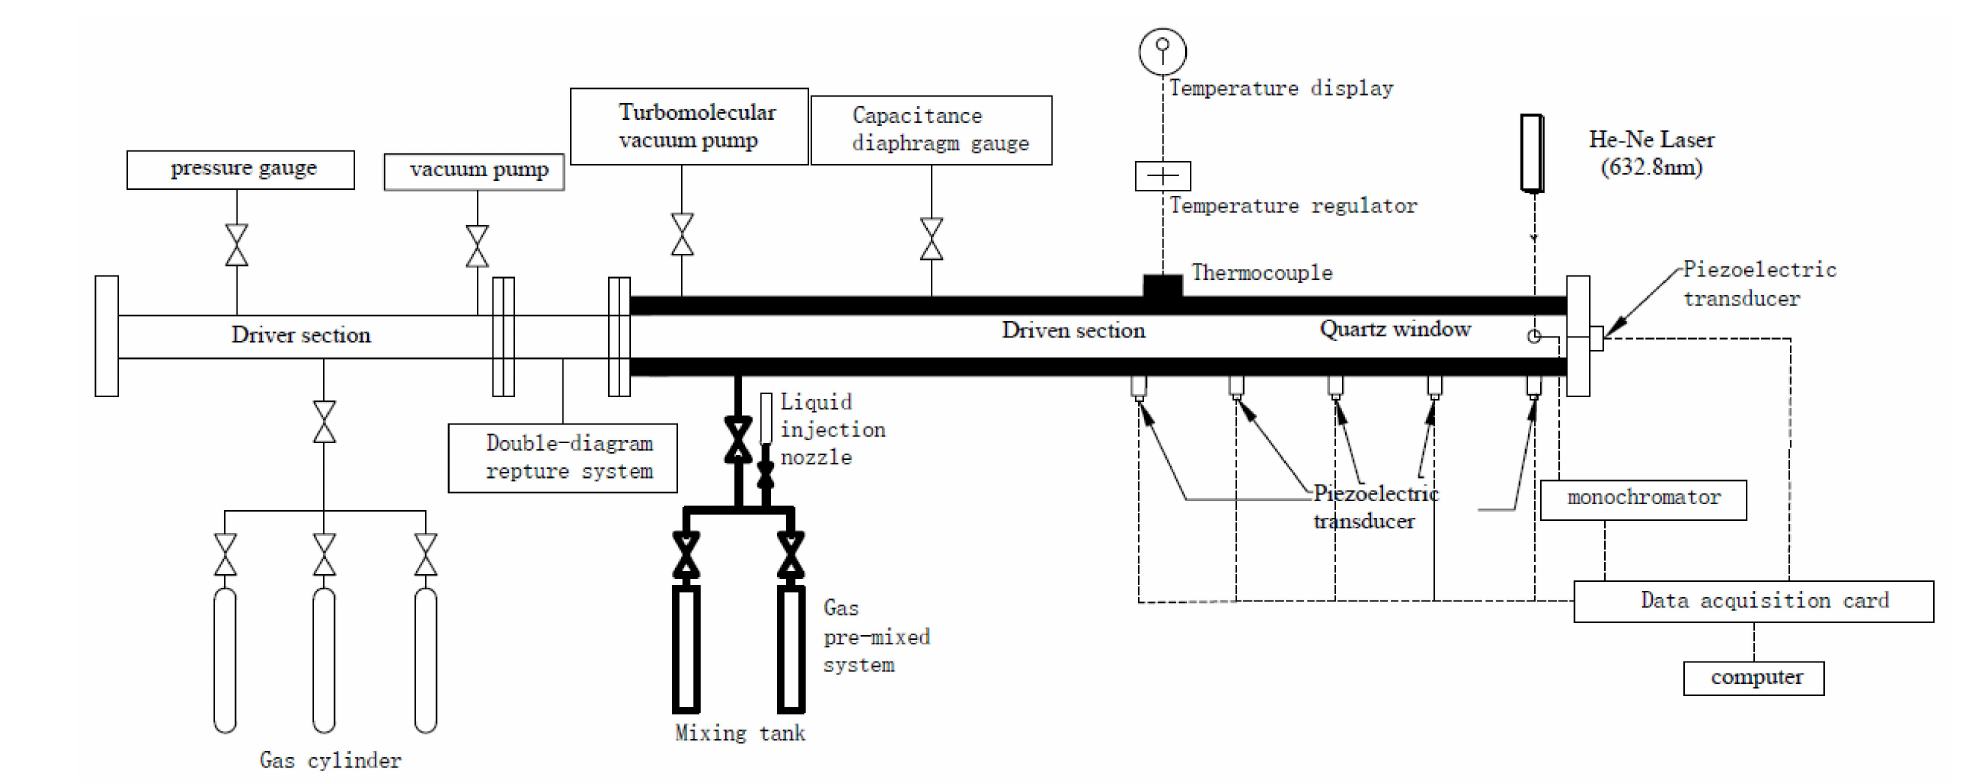
Figure 3. High-pressure shock tube schematic